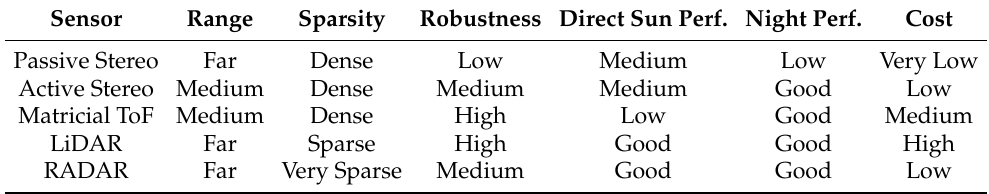
Table 1. Qualitative comparison between depth sensors. More details reported at [10,41,43]. Sensor Range Sparsity Robustness Direct Sun Perf. Night